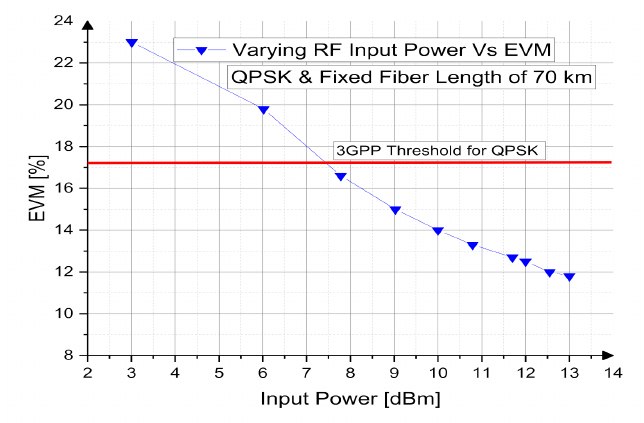
Figure 19. EVM results obtained for varying RF input power levels for a fixed fiber length of 70 km using QPSK as a modulation